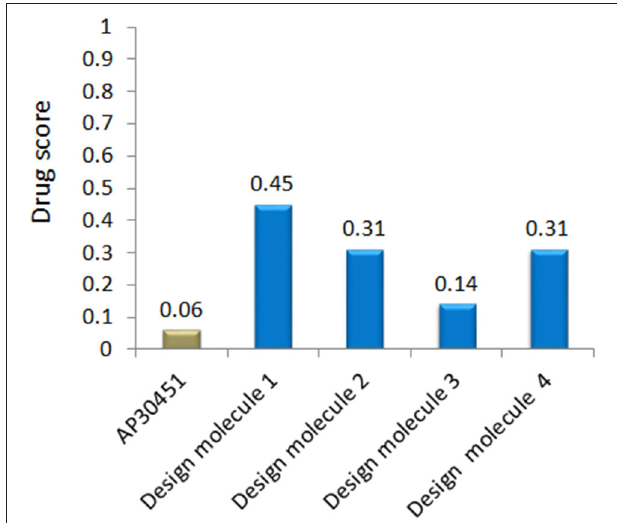
FIGURE 12 | Drug score of WNV inhibitor.